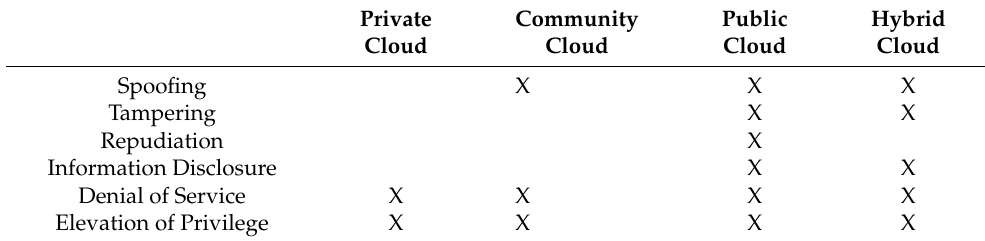
Table 6. Cloud deployment STRIDE